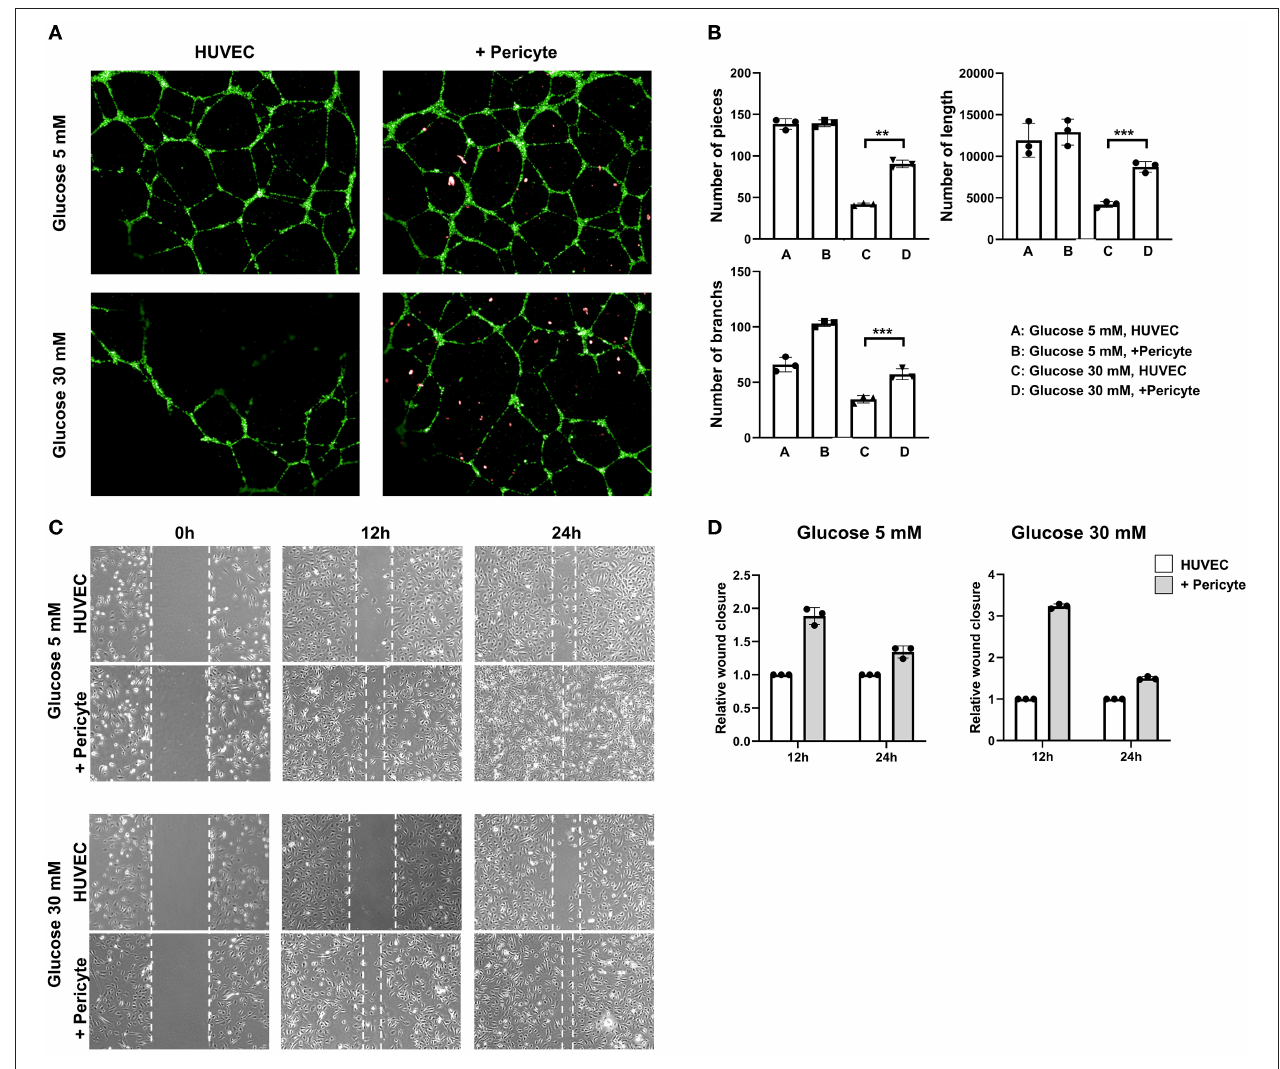
FIGURE 2 | The group with pericytes showed improved tube formation and cell migration ability in the high glucose condition. (A) The in-vitro vascular, tube formation assay showed effects of exposure on FITC-tagged human umbilical vein endothelial cell (HUVEC) tube formation with and without PE-tagged human pericyte cells. The optimal observation time for tube formation was 8h after seeding. In high glucose conditions, HUVECs with pericytes (10:1 ratio) showed active tube formation even compared to the without pericyte group. (B) The number of pieces in the assay was measured. (** P < 0.01 and *** P < 0.001 according to the Student’s t -test). HUVEC tube formation capacity showed no significant difference in low glucose conditions. However, in high glucose conditions, the group with pericytes had a statistically significant increase in tube formation. (C) Photomicrographs were taken at 0, 12, and 24h following initiation of the wound. HUVEC migration, often termed as wound closure ability, was more remarkable in the group with pericytes in both the high and low glucose conditions. (D) The quantitative approach applied to the wound closure assay, showing a histogram calculated based on the group breath ratio of the control group and the group with